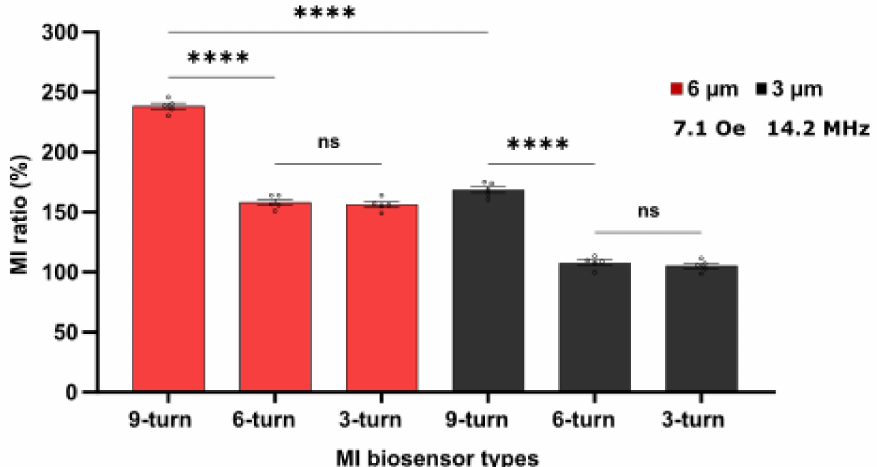
Figure 8. Comparison of the MI biosensor types (3-, 6-, 9-turn) with 6 µ m thickness (red bar) and 3 µ m thickness (black bar). The dot with the error bar represents the mean and standard error of the mean ( ± SEM), n = 5. The statistical significance is based on the ordinary one-way ANOVA (multiple comparisons) whereas p = 0.0605 (non-significant, ns), and <0.0001